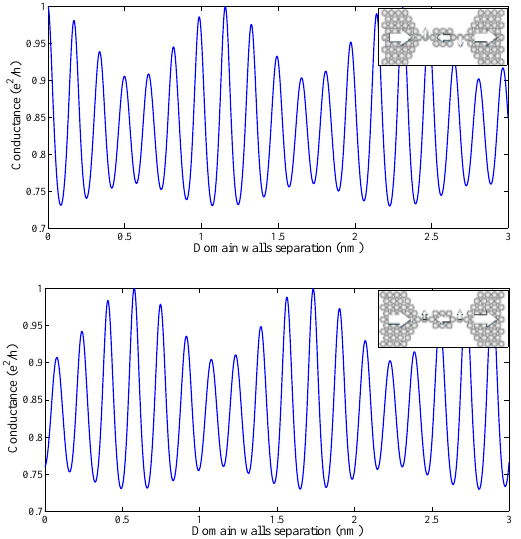
Fig. 2. Plot of conductance as a function of domain walls separation without considering the spin-orbit coupling effects in two parallel (lower) and anti-parallel (upper) configurations of magnetization at the noncontacts.